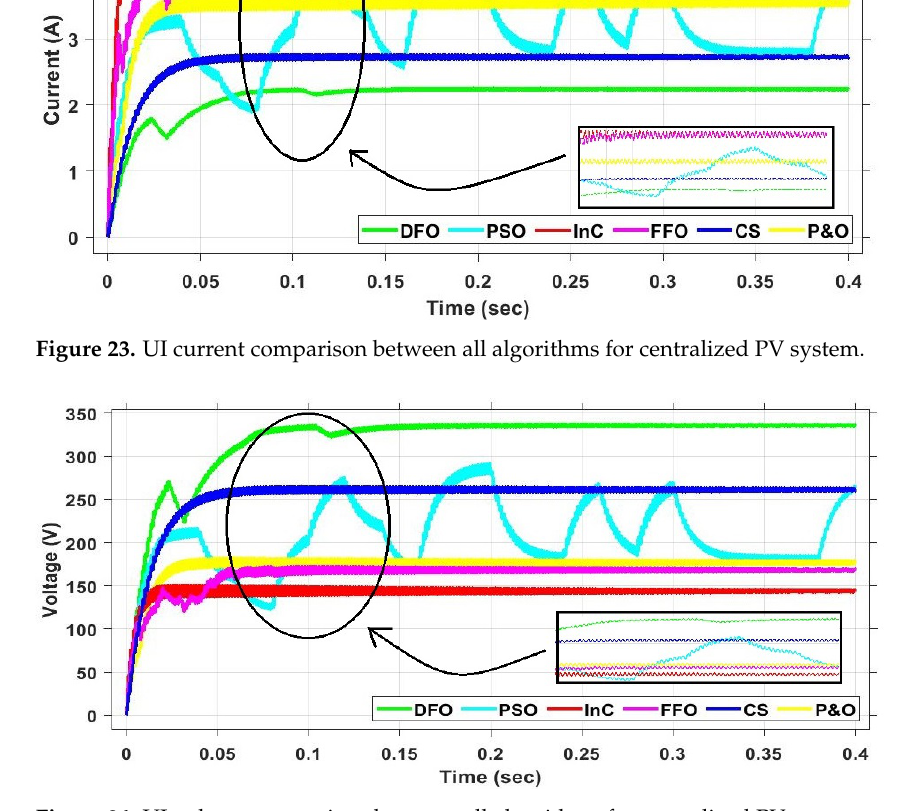
Figure 24. UI voltage comparison between all algorithms for centralized PV